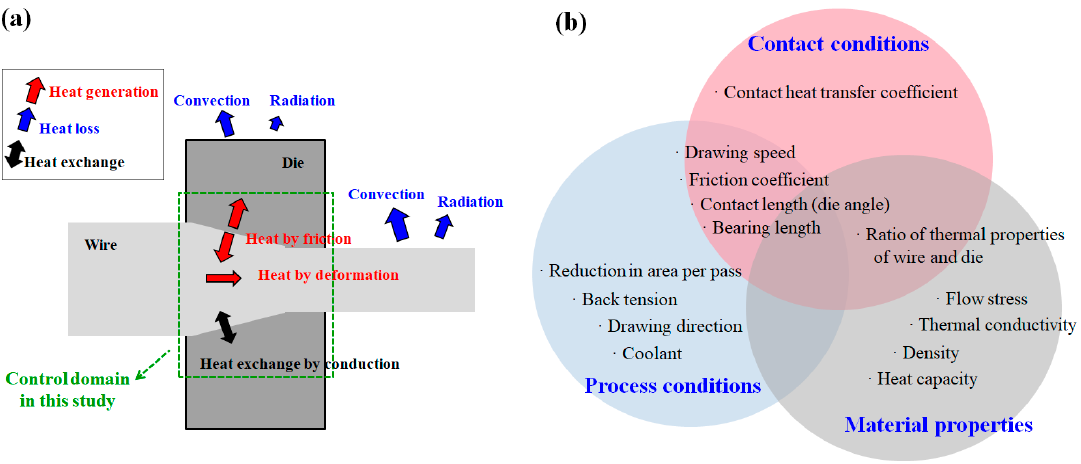
Figure 1. Schematic illustration showing ( a ) heat transfer mechanisms in wire drawing process and ( b ) general parameters affecting temperature distribution of specimen and die during wire drawing.